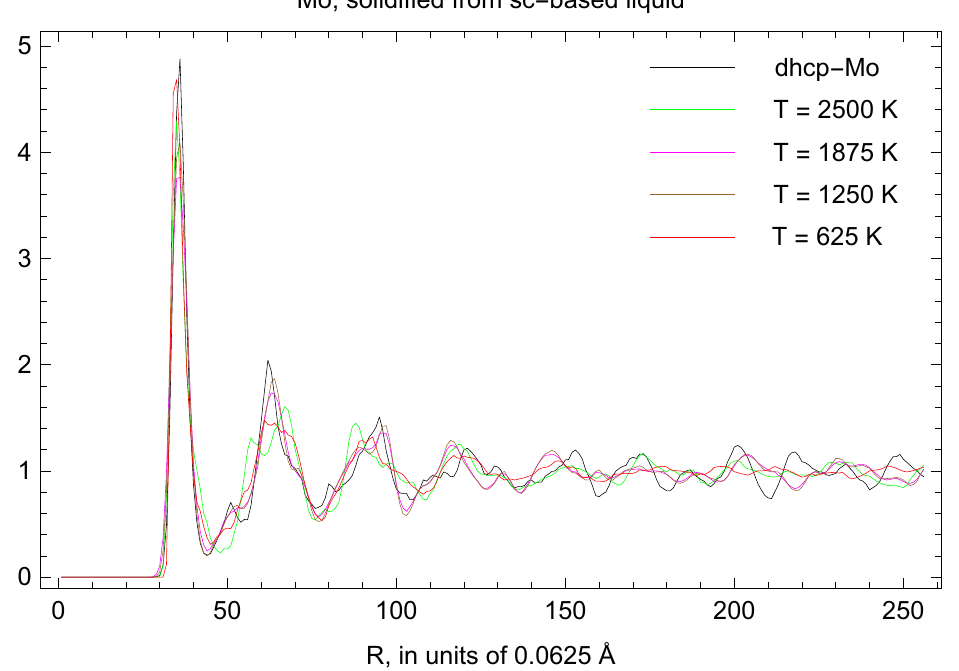
Figure 13. RDFs of the final states of the solidification of liquid Mo at ∼ 700 GPa at lower temperatures. RDF of dhcp-Mo at T = 2000 K is also shown for